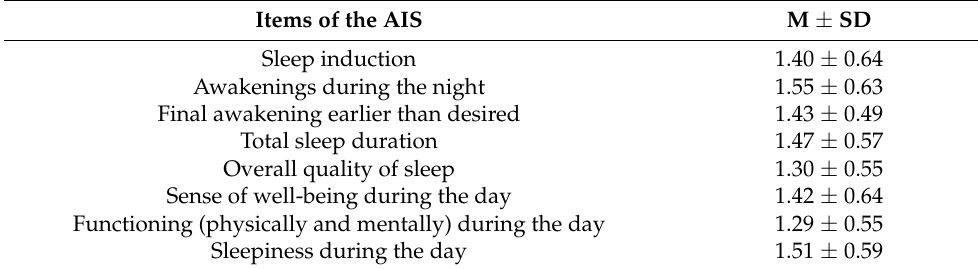
Table 3. Results for items of Athens Insomnia Scale (AIS) 1